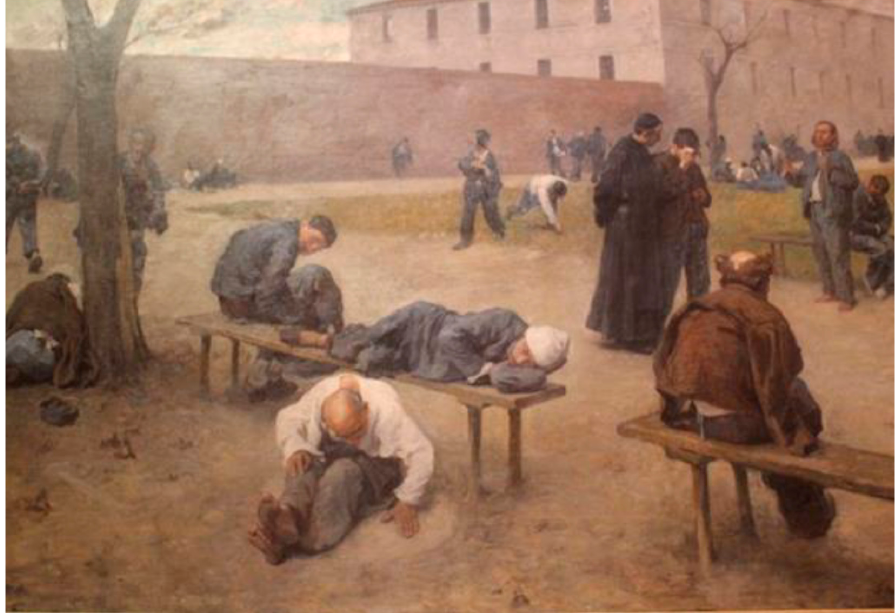
Figure 4. “Nosocomio,” Silvio Giulio Rotta, oil on canvas (200 × 300cm) 1895, National Gallery of Modern Art in Rome.